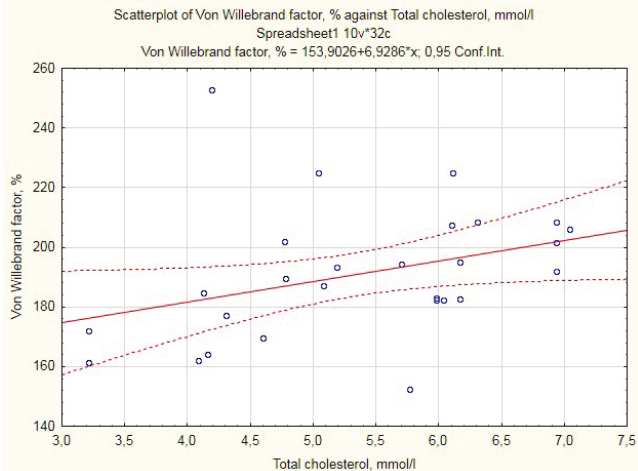
Figure 1- Correlation between the degree of von Willebrand factor and level of total cholesterol in hypertensive